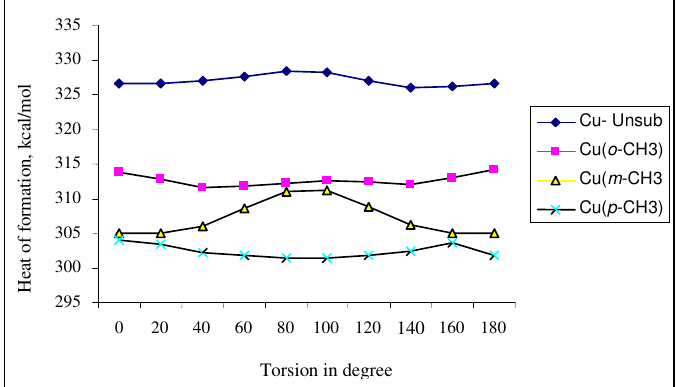
Figure 5. Torsion curves of un-substituted, ortho, meta and para- methyl Cu[C